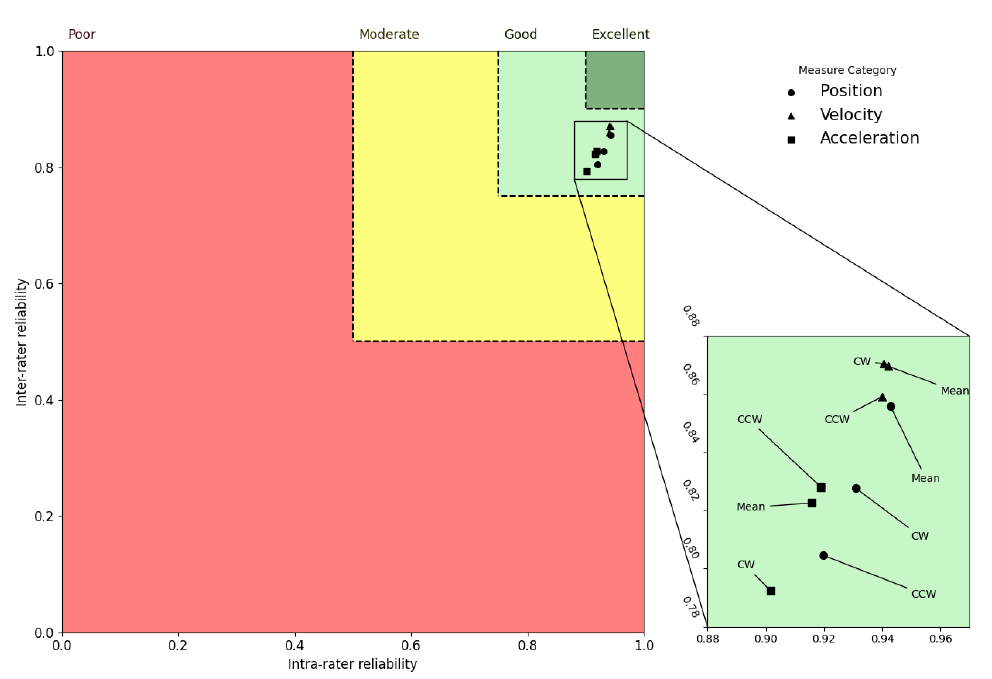
Figure 2. Axial plane inter-rater vs. intra-rater reliability. Regions with poor, moderate, good, and ex- cellent reliability are shown, respectively, in red, yellow, light green, and dark green. Circles, triangles, and squares are used to represent measures extracted from flexibility, velocity, and acceleration signals, respectively.